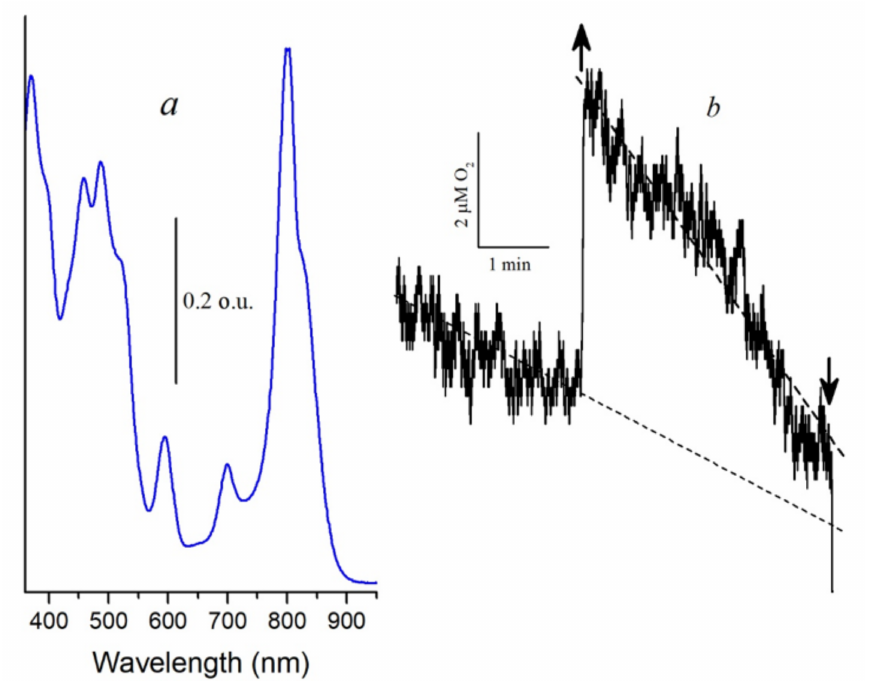
Figure 7. ( a ), Absorption spectra of LH2 complexes from Alc . vinosum after illumination for 60 min under blue light; ( b ), Histidine (20 mM) catalysed light-dependent oxygen uptake by isolated LH2 complexes from Alc vinosum with the preliminary bleached B850 band ( a ). Arrow up and down—light on and off,